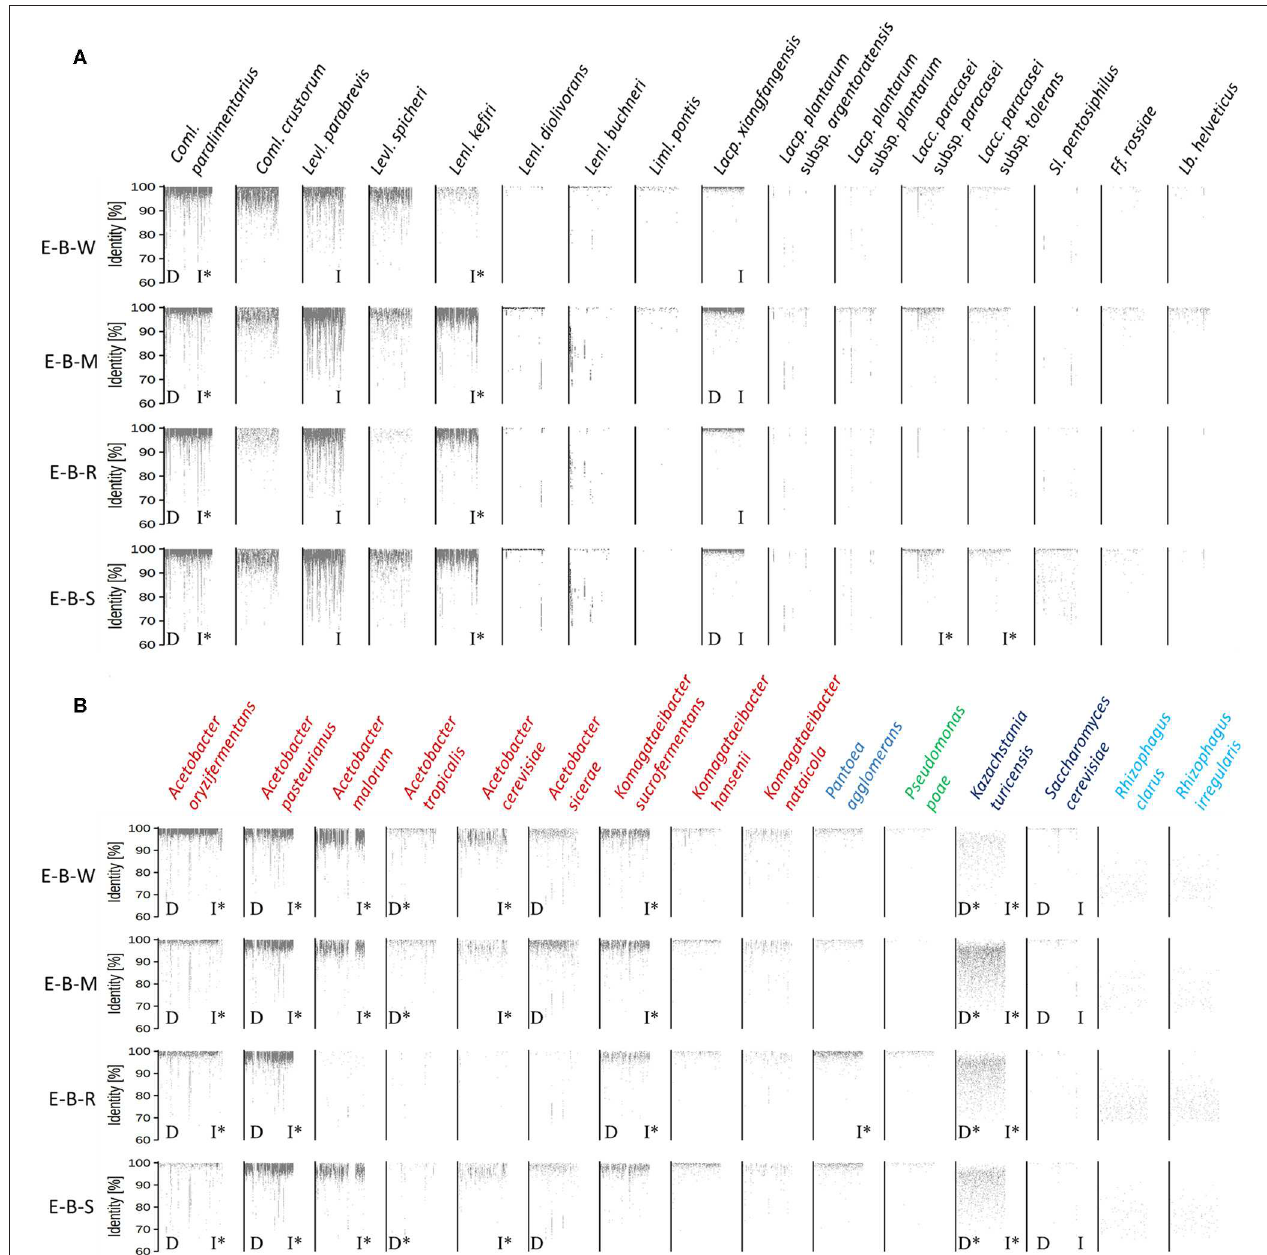
FIGURE 6 | Recruitment plots of metagenomic reads of lactic acid bacteria (A) and Gram-negative bacteria and yeast (B) species found in the sourdough samples E-B-W, E-B-M, E-B-R, and E-B-S from artisan bakery producer E. Each dot on the recruitment plots represents a bin of reads. The intensity of the color of the dot represents the normalized number of reads in a bin within a genome. Species found culture-dependently (D) and culture-independently through rRNA-PCR-DGGE community profiling or metagenetic analysis (I) are shown. The asterisk (*) is used when species closely related were found with the methods mentioned